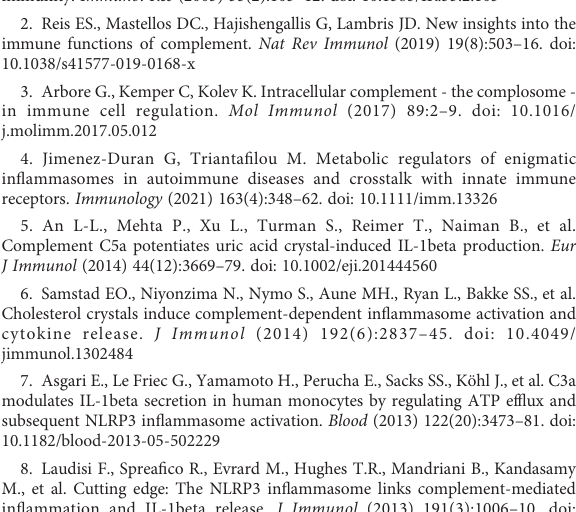
Statistical analysis in (B, D, G) was assessed by 1-way ANOVA with post- hoc Tukey ’ s test. Error bars represent ± S. E. M. SUPPLEMENTARY FIGURE 5 (A) WB quanti fi cation from , Prx3 dimerization measured by Image J and normalised to untreated (n=3). (B, C) Cells sensitised with neutralising anti-CD59 antibody and stimulated with puri fi ed components of MAC. (B) 6 µg/ml of C5b6 plus one molar excess of C7, C8 and C9, viability was measured by CellTiter-Glo (n=4). (C) MAC deposition after set up as in (B) measured by TCC MSD in cell lysates (n=3). (D) IL-18 release by hMDMs detected by IL-18 ELISA of supernatants of hMDMs in 1 million cells per condition (24-well plates) (same 3 donors from which contains additional positive and negative controls) stimulated with MAC for 3 hours with inhibitors 2-DG (5mM), HA (10 m M), and rotenone (0. 5 m M). Statistical analysis performed on (B – D) was assessed by unpaired student ’ s t-test with Welch ’ s correction for unequal SDs. Error bars represent ± S. E.